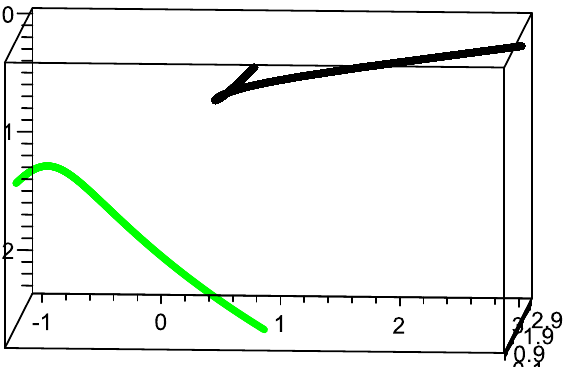
Figure 4. the lightlike curve (black curve) and its centrode (green